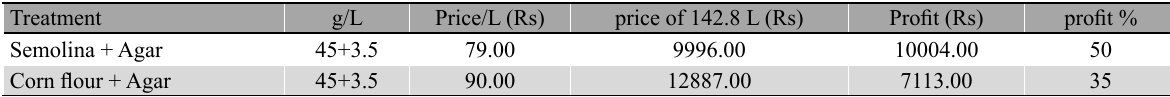
Table 6. Cost reduction in MS media combination of different gelling agent Treatment g/L Price/L (Rs)